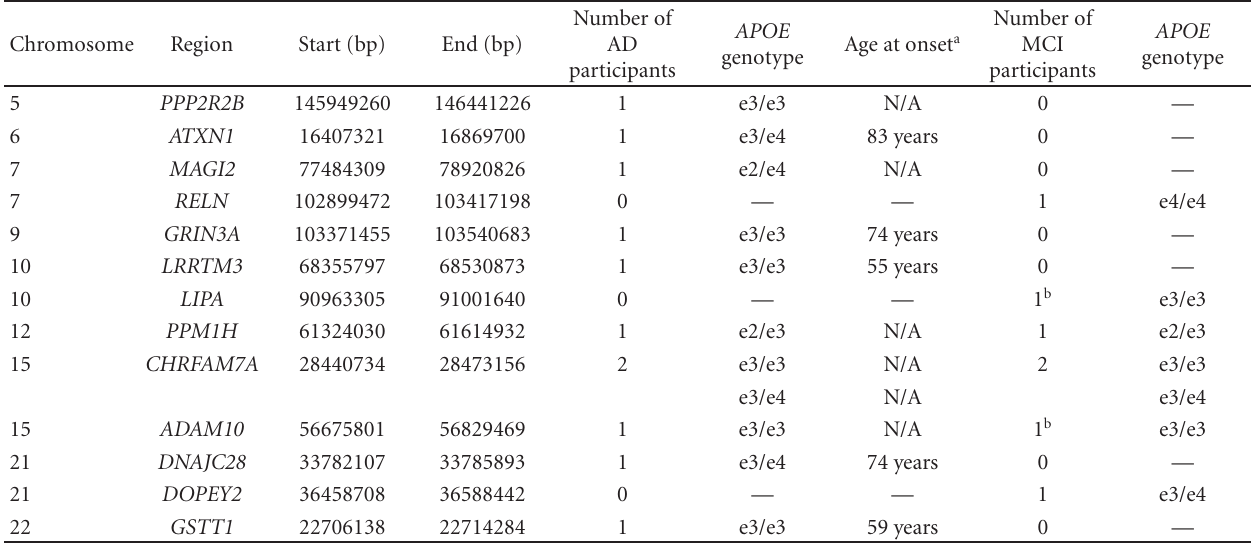
Table 4: Genes that have CNV calls from at least one Alzheimer’s disease (AD) and/or one mild cognitive impairment (MCI) participant and no healthy controls using the candidate gene